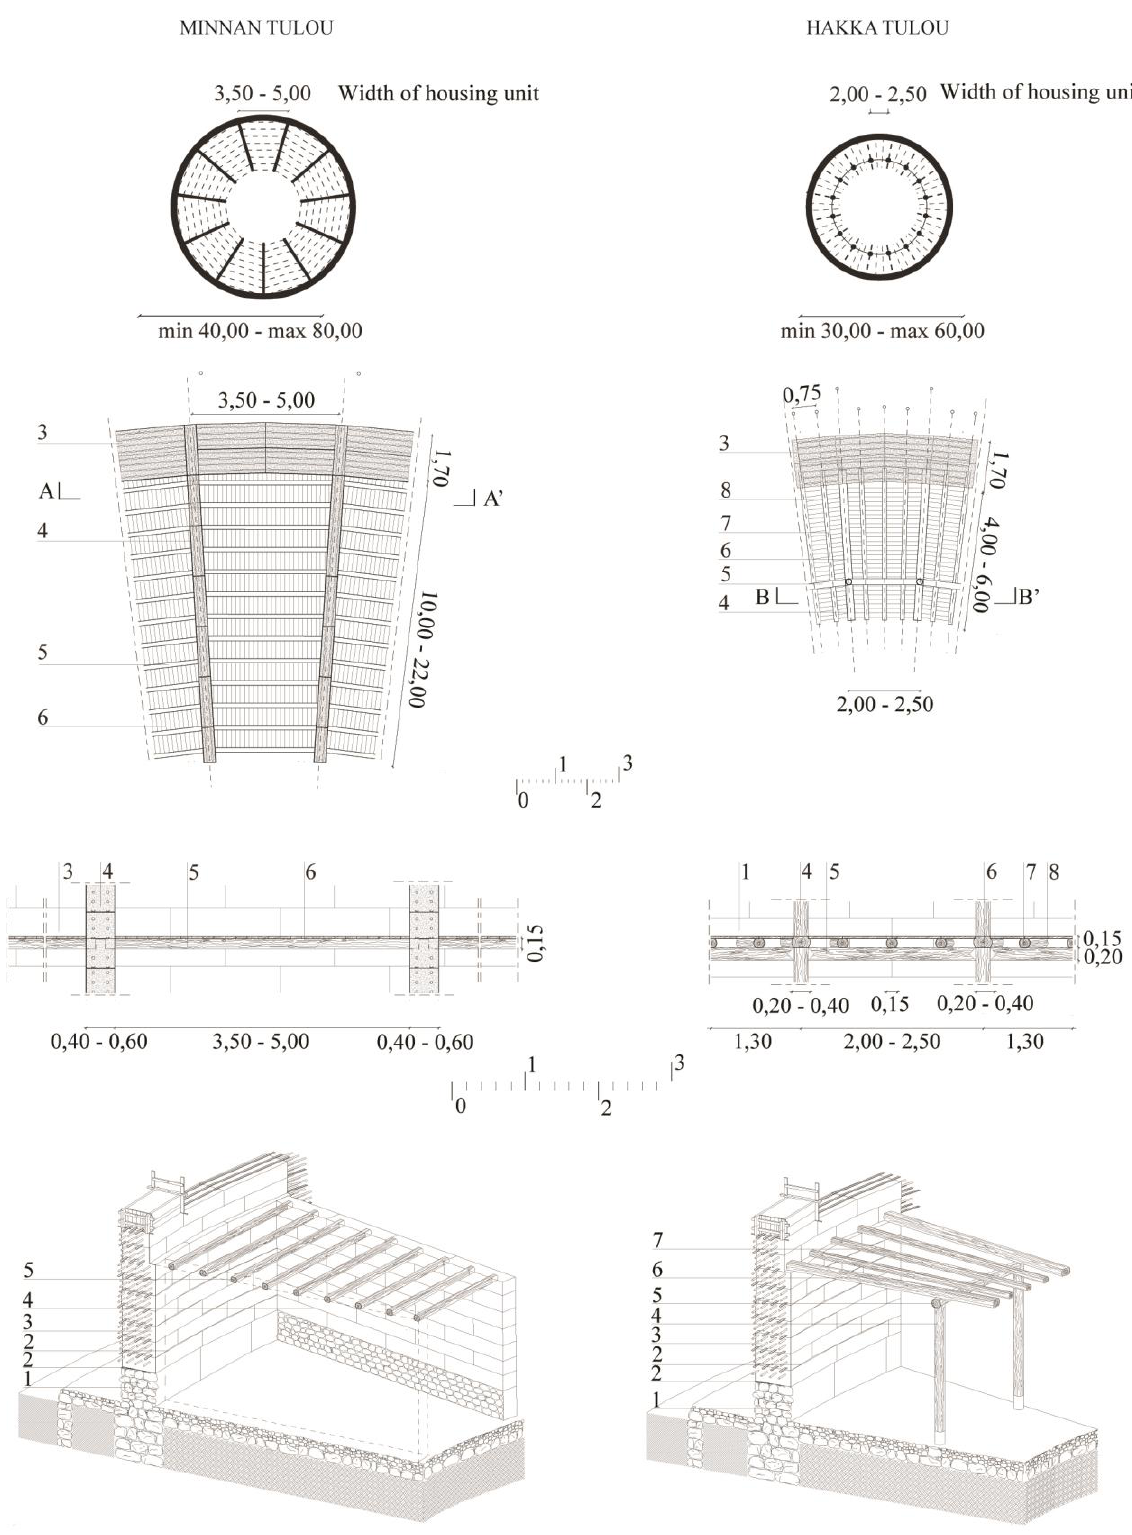
Figure 7. Constructive systems. On the left, Minnan type with rammed earth load-bearing walls and wooden circumferential beams (shānmù): 1. foundation and base in roundish river stone or, in rare cases, in chippings obtained from quarry crushing; 2. layer of bark to level the laying surface and to prevent moisture from rising; 3. rammed earth outer wall made of horizontal rows (wooden formworks H. 0.40, L. 1.50/2.00 approx.) with the insertion of bamboo reeds and shānmù branches in the mixture; 4. radial rammed earth load-bearing walls; 5. circumferential beams embedded in the rammed earth load-bearing walls; 6. plank floor. On the right, Hakka type with wooden frameworks (shānmù): 1-2-3. as per previous legend; 4. pillars with circular cross-section and stone base; 5. transfer (circumferential) beam, with shaped section, embedded between the pillars; 6. radial beams, with shaped section, in correspondence with vertical supports; 7. radial beams, with shaped cross-section, placed on the transfer beam (5); 8. plank floor.